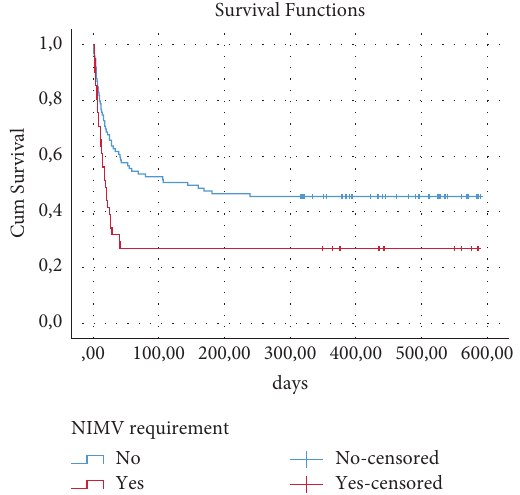
Figure 4: Kaplan–Meier survival analysis by noninvasive me- chanical ventilation requirement. Comparison between survivors and nonsurvivors NIMV, noninvasive mechanic ventilation